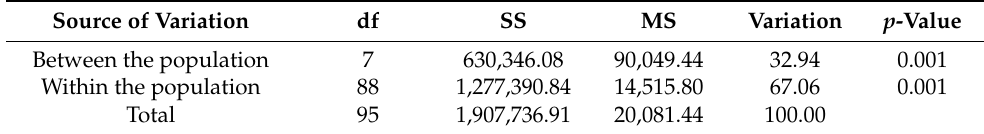
Table 3. Analysis of molecular variance (AMOVA) based on the population as being the source of the genetic variation.